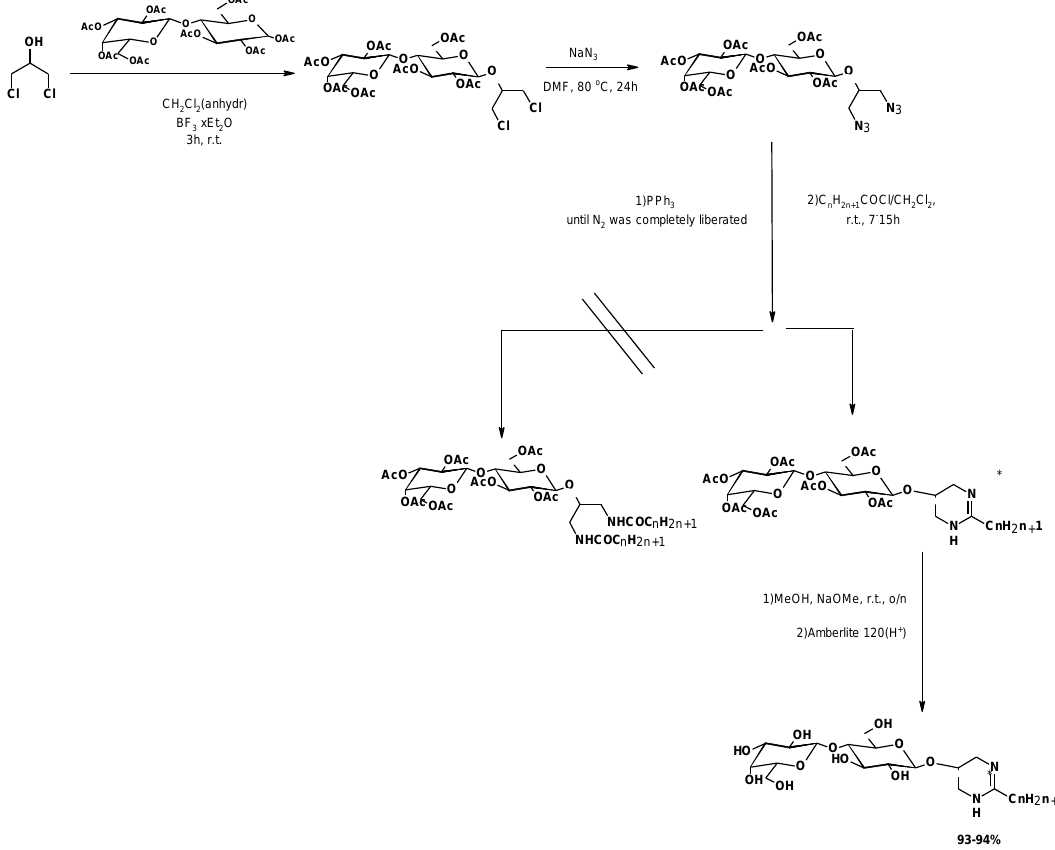
Figure 14. Staudinger reaction of lactose based diazides with fatty acids.